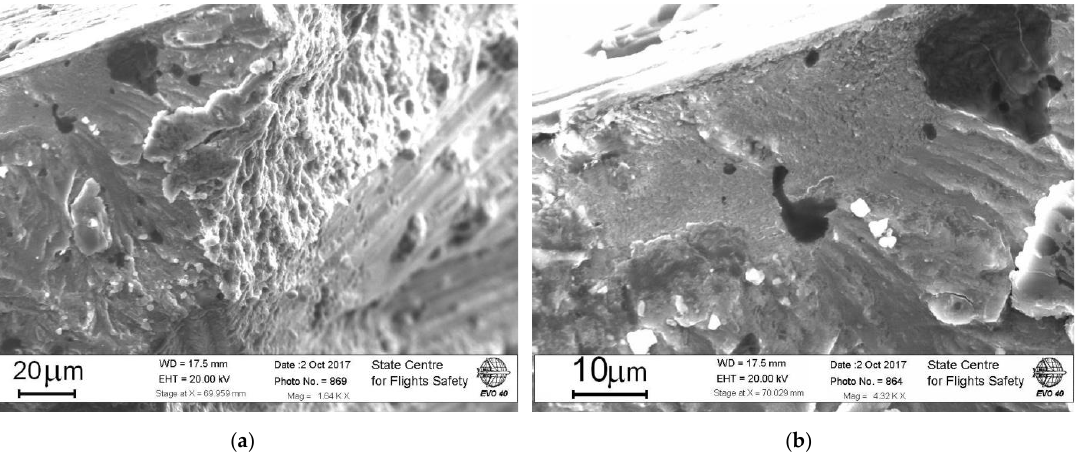
Figure 9. The fracture surface of hot-rolled aluminum alloy specimen with ( a ) surface and ( b ) subsurface crack initiation. The stage II of crack growth produces numerous of quasi brittle platelets. Since spec- imens were machined so that its axis matches with the bar axis, these elongated platelets are not related to the material structure produced during extrusion.